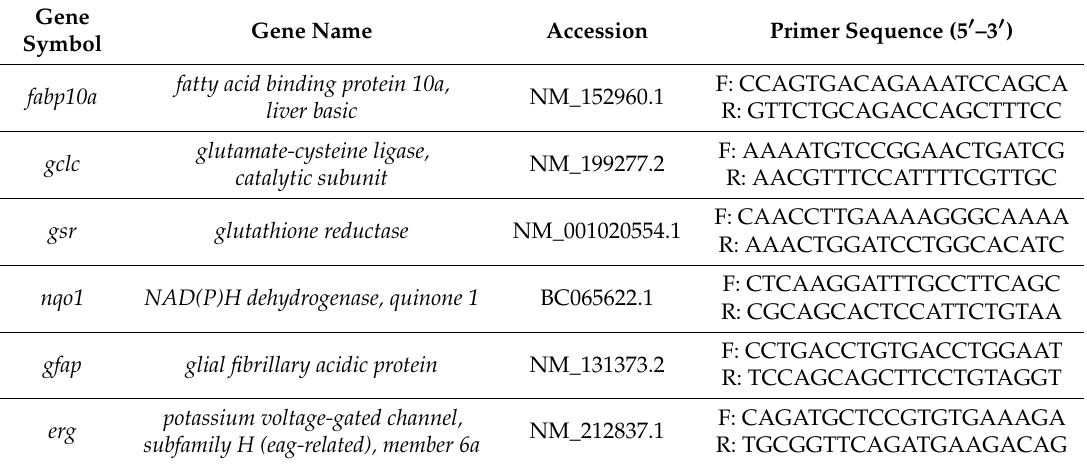
Table 5. The primers sequence of toxicity genes in embryonic